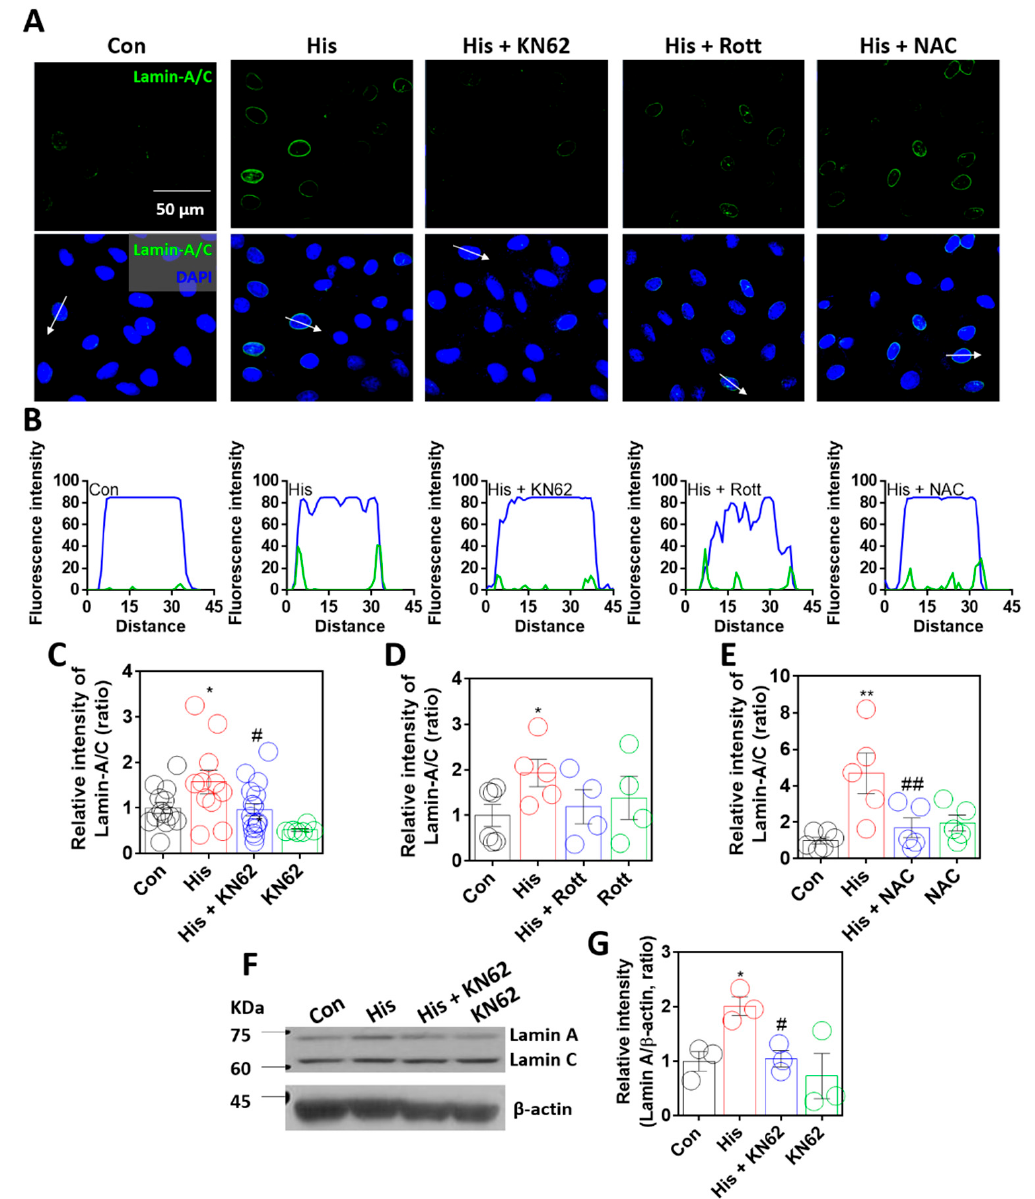
Figure 3. Lamin-A/C expression was dependent on Ca/CaMKII activation. ( A ) Immunofluorescence staining of lamin-A/C (green) and DAPI (blue) after histamine (His) treatment (100 µ M, 24 h) with and without KN-62 (10 µ M, 24 h), rottlerin (Rott; 2 µ M, 24 h), or NAC (1 mM, 24 h) in A549 cells. Scale bar represents 50 µ m. Lower panels were merged images. ( B ) Fluorescence intensity in the sectional distance of cells indicated by white arrows. Green and blue lines indicated lamin-A/C and DAPI, respectively. The graph indicates relative intensity of lamin-A/C after histamine treatment (100 µ M, 24 h) with or without ( C ) KN-62 (10 µ M, 24 h), ( D ) Rottlerin (2 µ M, 24 h), or ( E ) NAC (1 mM, 24 h). The bars represent the mean ± SEM ( n = 4~16, * p < 0.05 or ** < 0.01 vs. control and # p < 0.05 or ## p < 0.01 vs. His-treated group). ( F ) Protein expression levels of lamin-A/C after histamine treatment (100 µ M, 24 h) with or without KN-62 (10 µ M, 24 h) in A549 cells. ( G ) The graph indicates relative intensity of lamin-A. The bars represent the mean ± SEM ( n = 3, * p < 0.05 vs. control and # p < 0.05 vs. His-treated group). β -actin was used as a loading control.